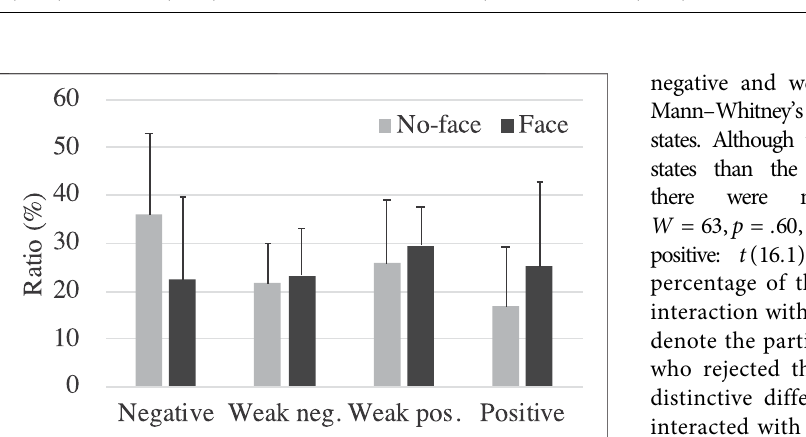
FIGURE 3 | Total time of caring behaviors presented by each participant during interaction in the (A) face group and (B) no-face group. Letters indicate each participant. * shows participants who refused the robot. The alphabets denote the participant IDs.